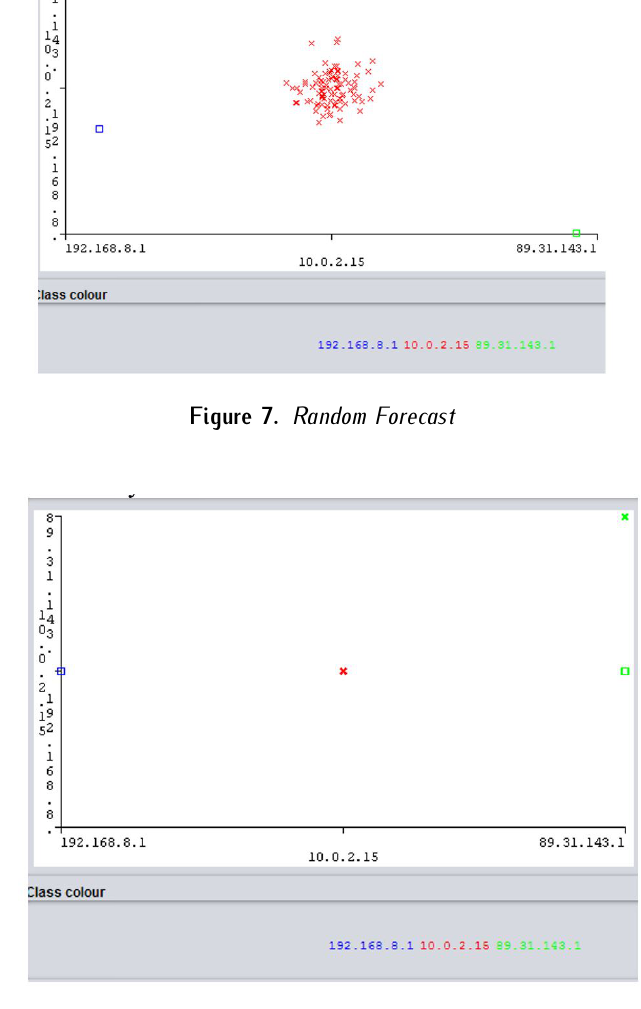
Figure 8. Result